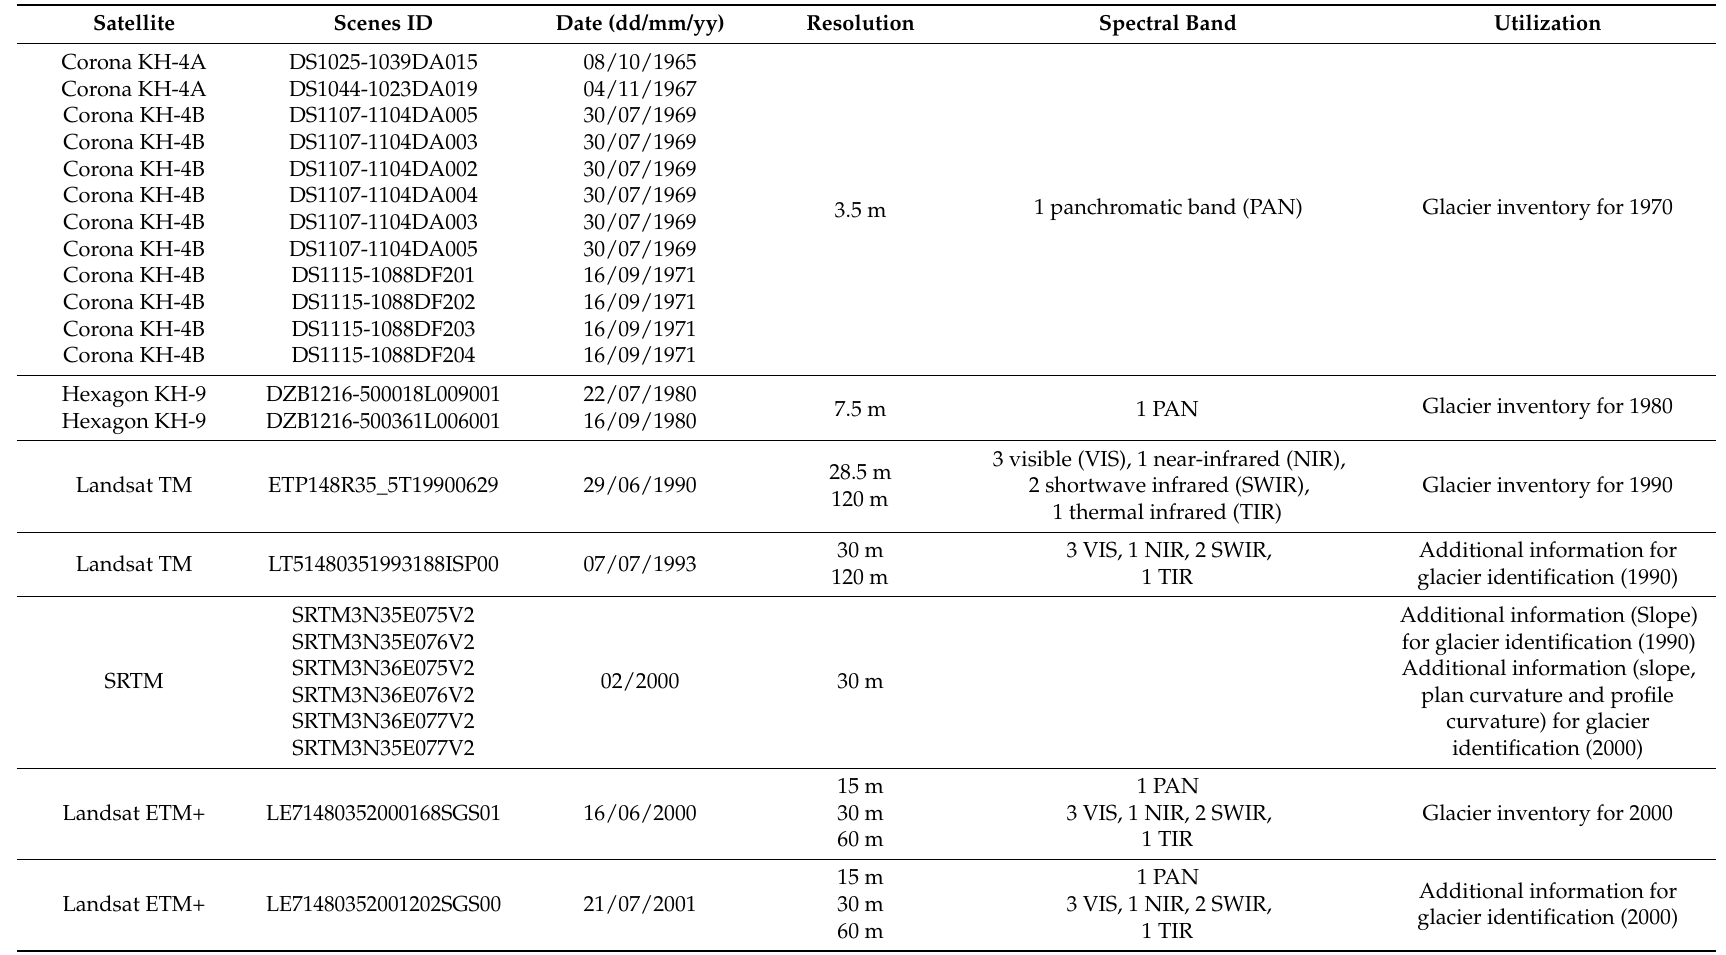
Table 1. Data used in this